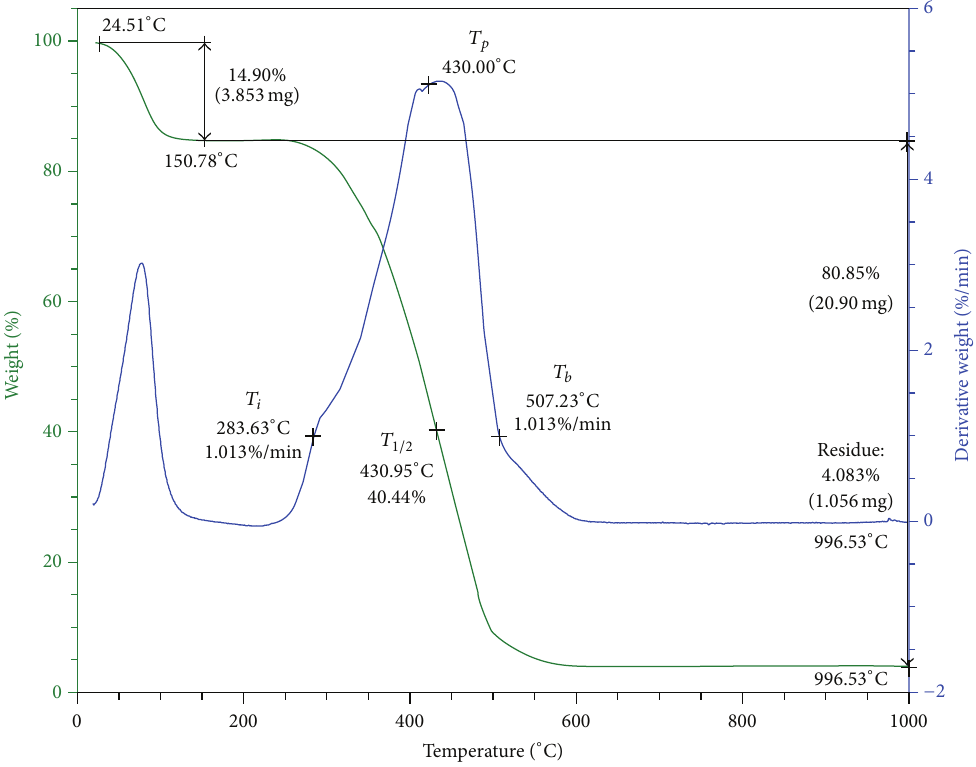
Figure 6: TGA/DSC combustion thermogram for Owukpa